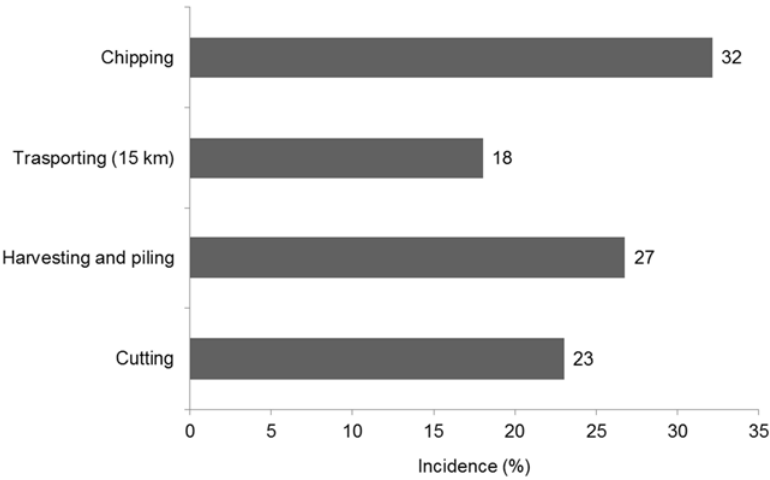
Figure 5. Breakdown of the single operations on the total woodchip production cost.